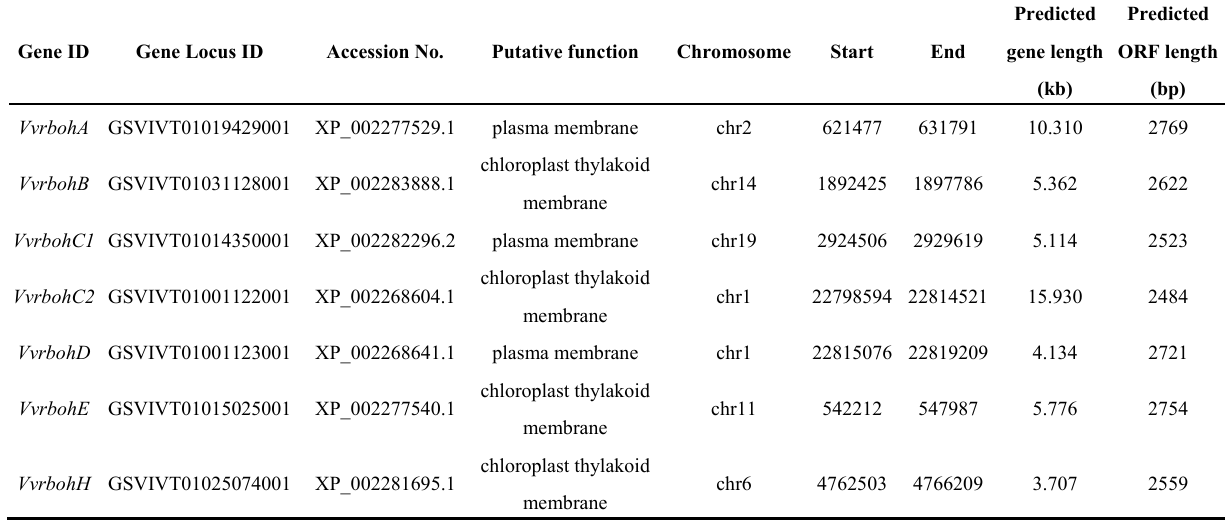
Table1. RBOH genes in